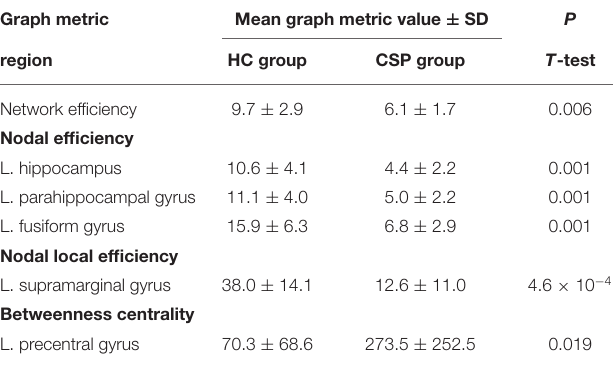
( Table 1 ). All motor-related tracts converge in the vicinity of the caudal SMATT regions. Thus, regardless of the